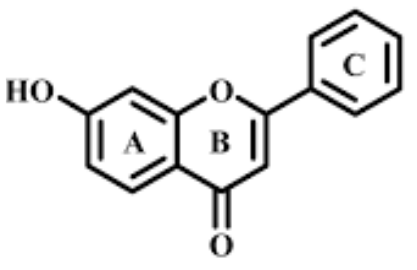
Figure 1. Structure of 7-hydroxyflavone, 7-HF.